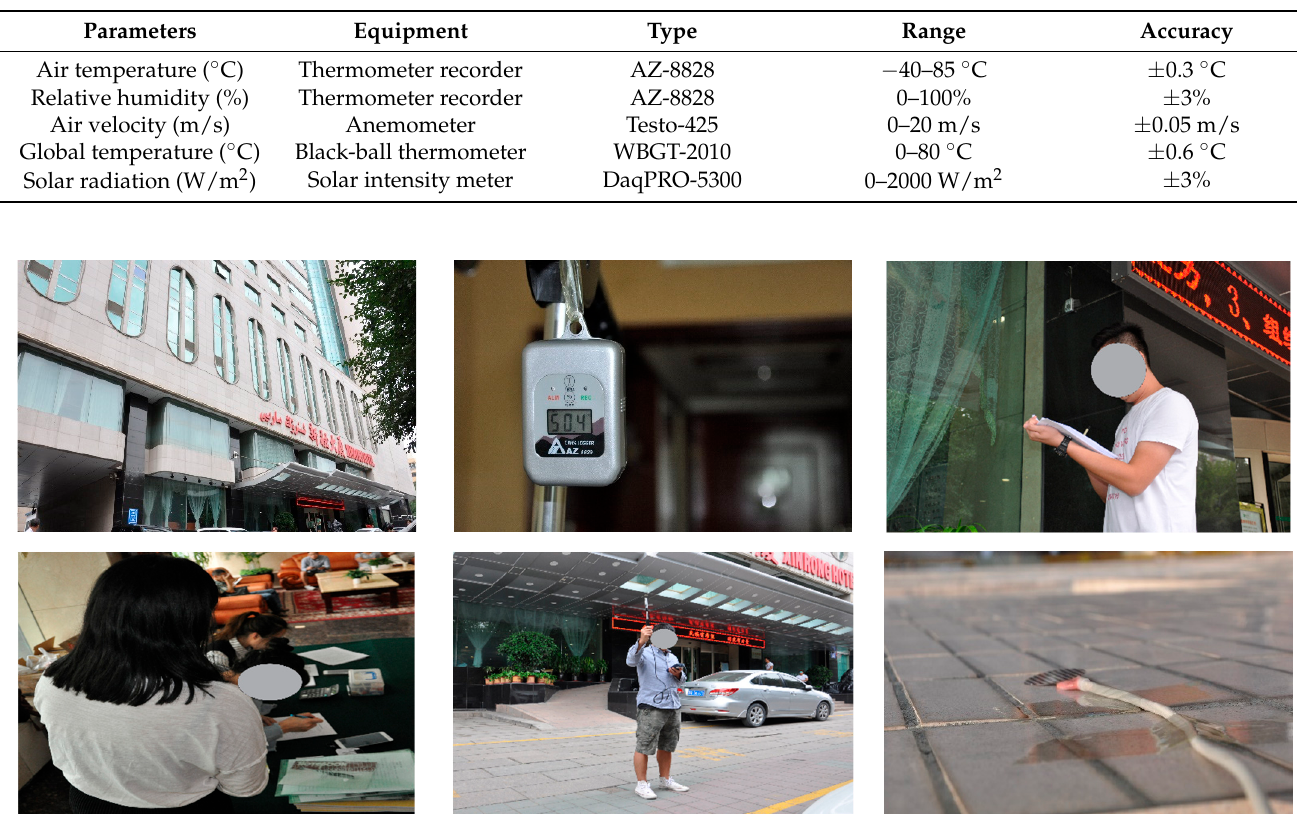
Table 5. The detail parameters of test instruments.